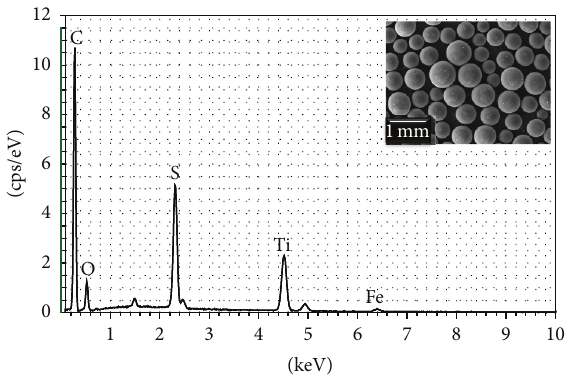
Figure 1: SEM image and EDS spectrum of 0.6 wt% Fe-TiO 2 /SAC.